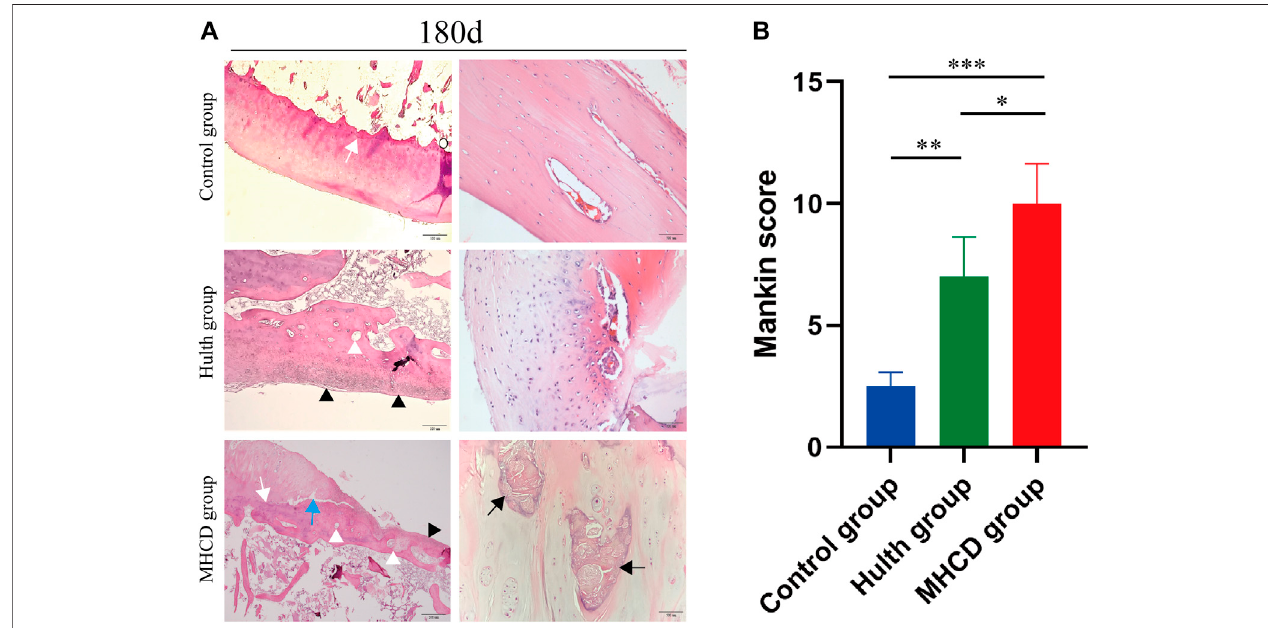
FIGURE7| Pathologicalmorphologyofarticularcartilage180 daysaftersurgery. (A) RepresentativeimagesshowingH&Estainingoftheweight-bearingsurfaceof the medial femoral condyle and femoral posterior condylar cartilage from the Control, Hulth, and MHCD groups. (White arrow: tidemark, White arrowhead: subchondral cyst,Blackarrow:sclerosis,Blackarrowhead: fi brocartilagemineralization,Bluearrow:degradationofcartilagematrix) (B) Histologicscoresofthecartilagelesionsinthe three groups. * p < 0.05, ** p < 0.01, *** p < 0.001. Data are presented as the mean ± SD.